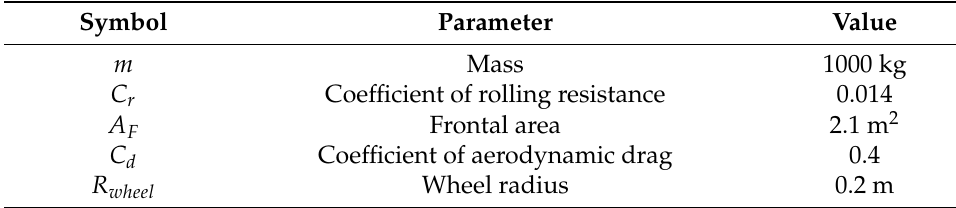
Table 3. Specifications of EV.